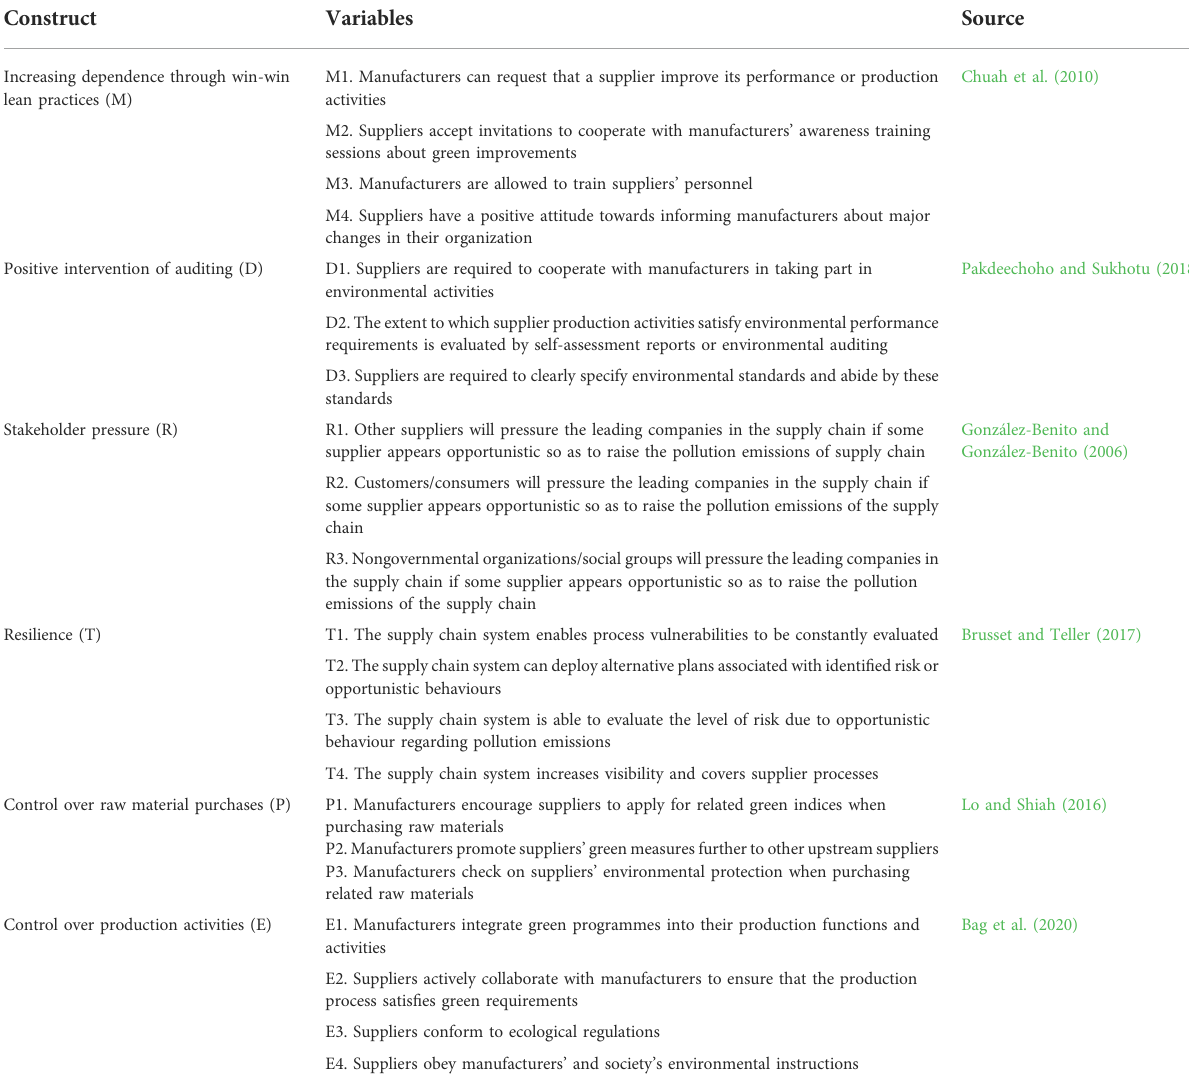
TABLE 1 Questionnaire content, operationalization, variables for each construct and their